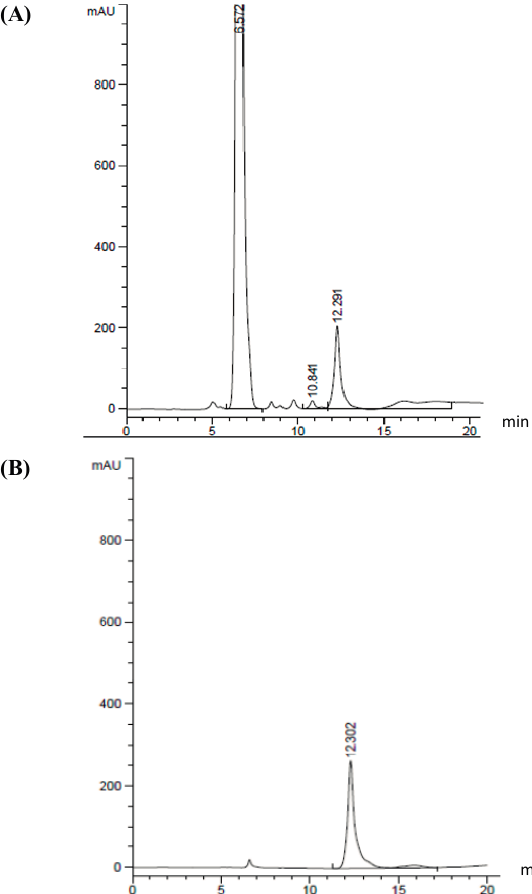
Figure 2. Representative chromatogram of GABA production using Lactobacillus plantarum Taj-Apis362 ( A ) and standard GABA ( B